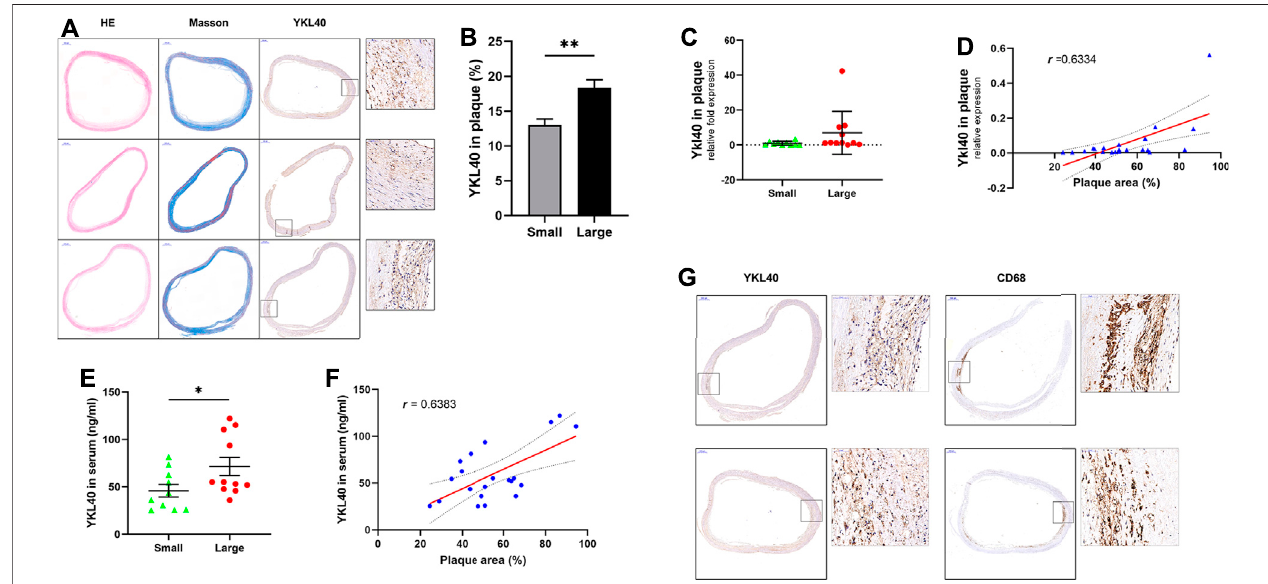
FIGURE1 |(A) H&E, Masson stainingand anti-YKL-40 Ablabelingwere performed on carotid plauqe samples. (B) Relative expression level ofYKL-40in unit area ofplaqueswerecalculatedbasedonimmunohistochemistry.TheYKL-40expressionlevelinthelargegroupwassigni fi cantlyhigherthaninthesmallgroup( p (cid:1) 0.0034). (C,D) The mRNA expression level ofYKL-40 in plaque tissueswere detected via qRT-PCR.Signi fi cantpositivecorrelationexisted betweenthe Ykl40 expression level in theplaquetissuesand plaque relative area( r (cid:1) 0.6334, p (cid:1) 0.0021), but thedifference betweentwogroupswasnotsigni fi cant( p > 0.05). (E,F) YKL-40expression level in serum samples were detected by ELISA assay. The YKL-40 expression level in serum was signi fi cantly higher in the large group than in the small group ( p (cid:1) 0.0447) and was signi fi cantly positively correlated with plaque relative area ( r (cid:1) 0.6383, p (cid:1) 0.0018). (G) Colocalization between YKL-40 and macrophages in plaque tissues as indicated by immunohistochemical